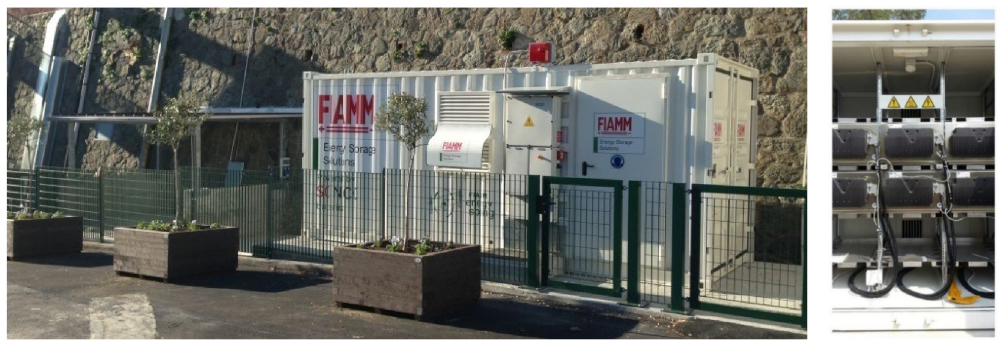
Figure 6. Electrical storage system of the SPM [35].